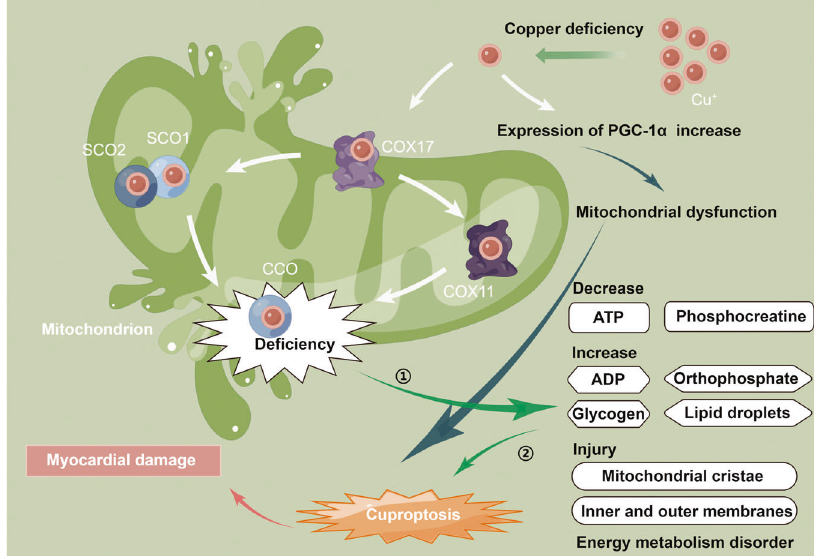
Fig. 3 Mitochondria and copper in CVD. When copper de fi ciency reduces the activity of CCO, the level of ATP and phosphocreatine in the heart and other tissues decreases, whereas the content of ADP, orthophosphate, glycogen, and lipid droplets increases. Mitochondrial cristae and inner and outer membranes are altered, eventually leading to mitochondrial rupture. Additionally, copper de fi ciency increases the level of PGC-1 α , causing mitochondrial dysfunction. These changes interfere with energy metabolism and cause myocardial damage. CVD cardiovascular disease, CCO cytochrome C oxidase, COX11 cytochrome c oxidase copper chaperone 11, COX17 cytochrome C oxidase copper chaperone 17, PGC-1 α peroxisome proliferator-activated receptor-gamma coactivator-1 alpha protein, SCO1 synthesis of cytochrome C oxidase 1, SCO2 synthesis of cytochrome C oxidase 2. The fi gure was created with Figdraw (https://www. fi